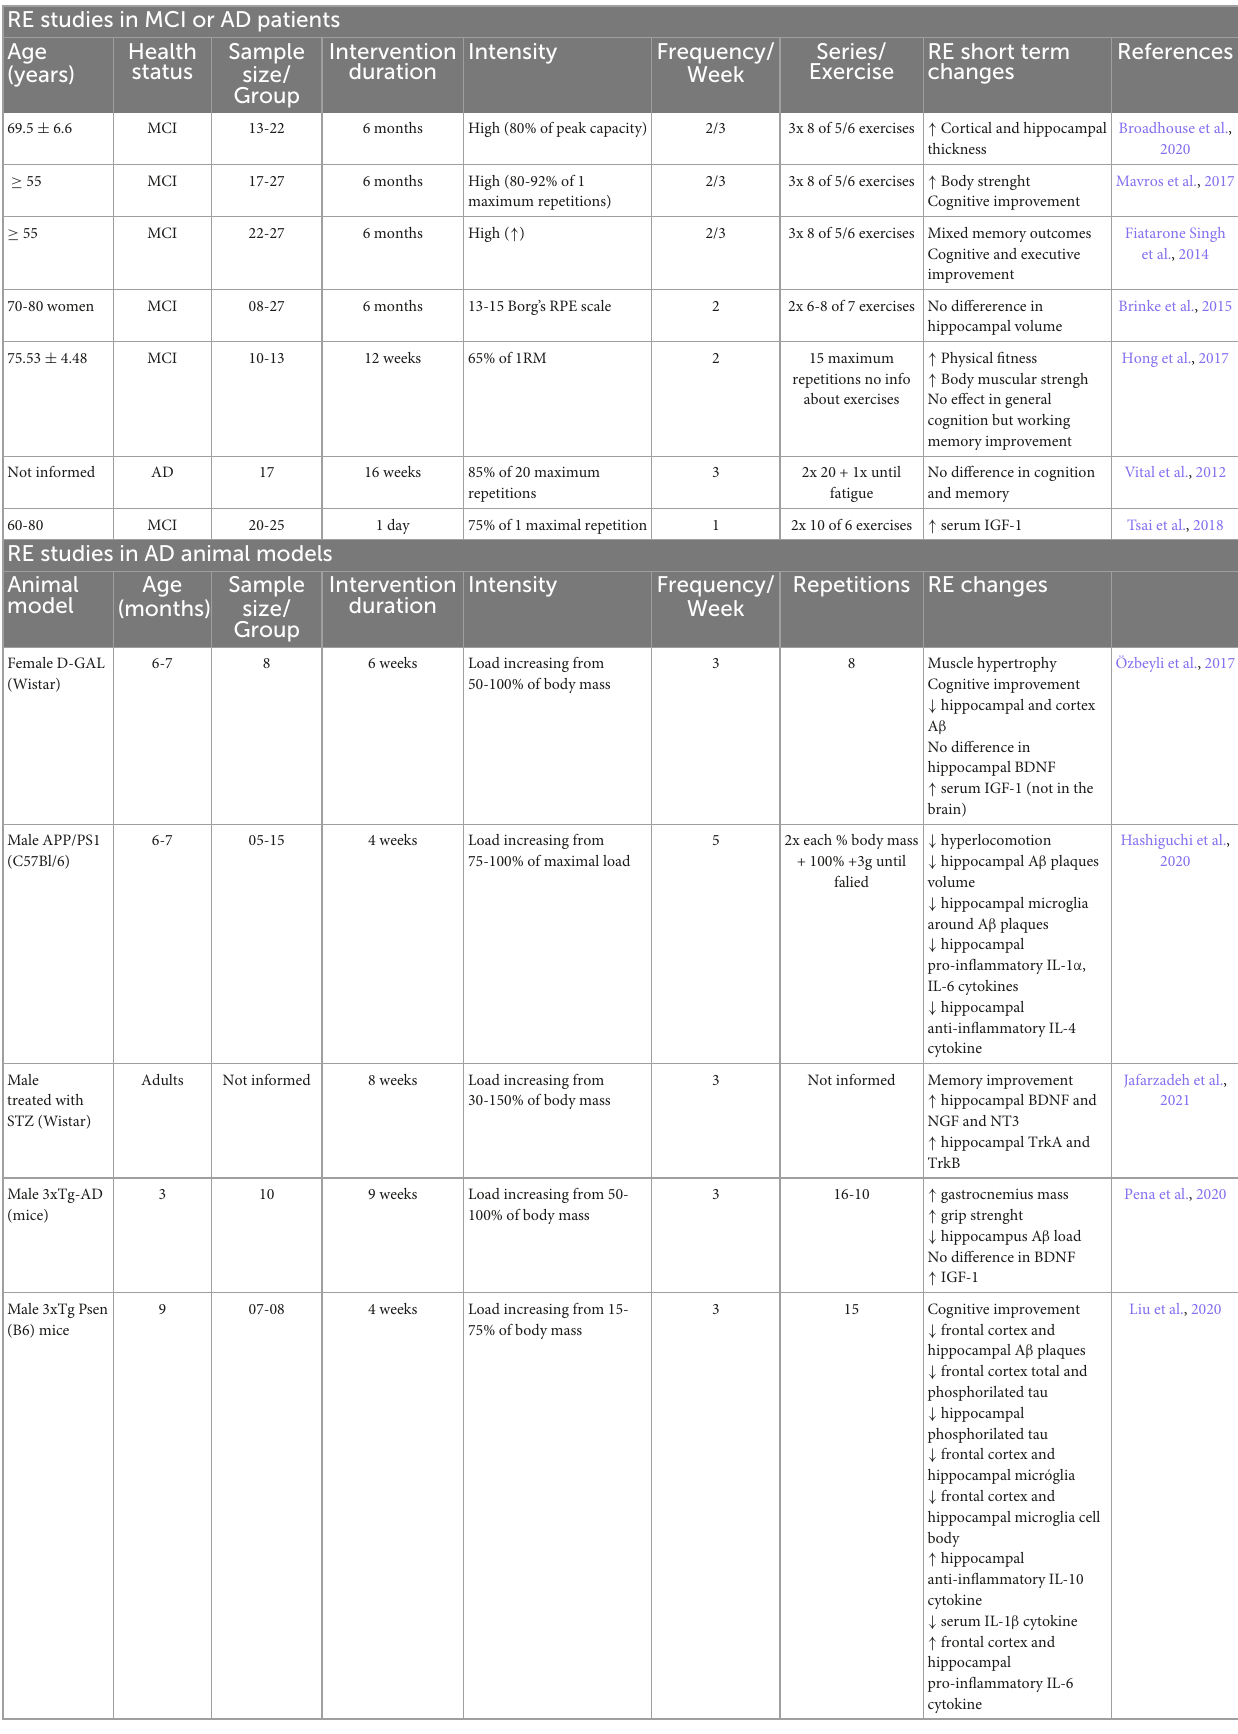
TABLE 1 Summary of studies using RE in patients with MCI or AD and in animal models of AD. RE studies in MCI or AD